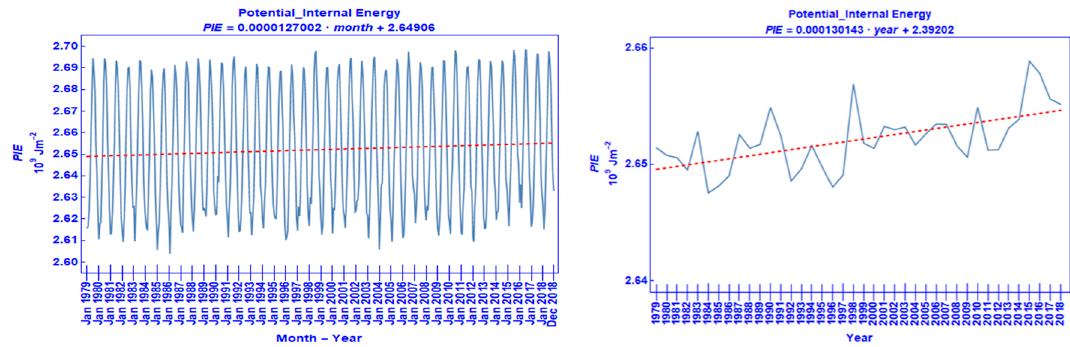
Figure 8. The same as Figure 2, but for PIE .